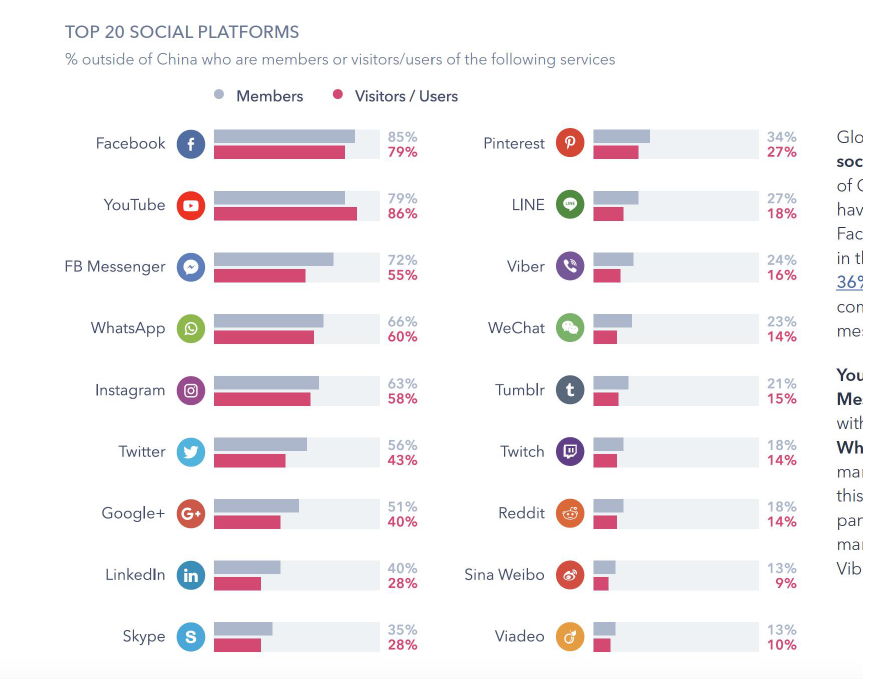
Figure 1. Users of social media. Source: Report 2018. Global Web Index. Report in social media.